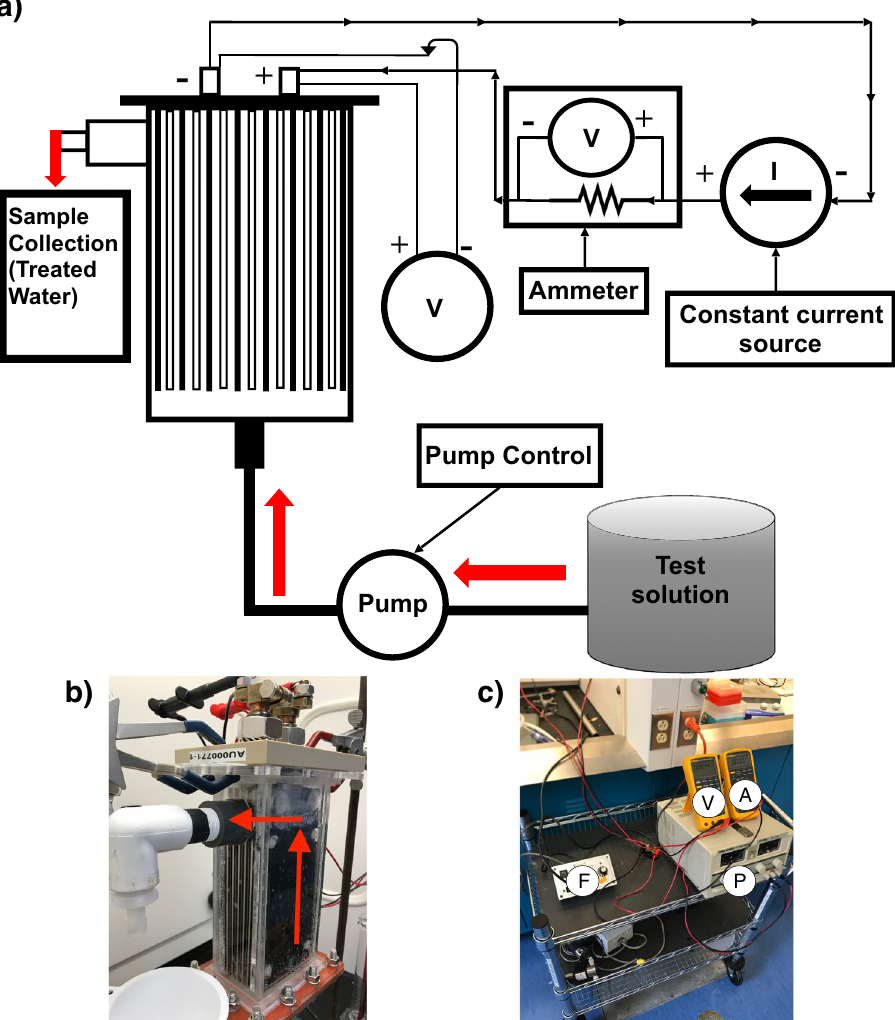
Figure 2. Overview of the Electrochemical Flow Cell (EFC) and supporting hardware. ( a ) Electrochemical Flow Cell (EFC) testbed schematic showing the principle components and the direction of the electrical current depicted by arrows used for the experimental setup and ( b ) the EFC with red arrows depicting the flow path and ( c ) monitoring and controlling components for flow rate (F), current (A), voltage (V), and the use of the power supply